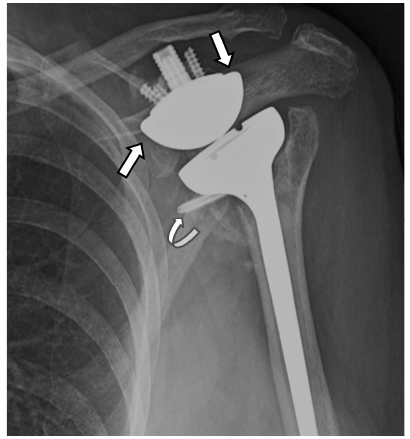
Figure 23. Frontal radiograph in a patient with an RTSA shows fracture/break (arrows) of three of the baseplate screws.